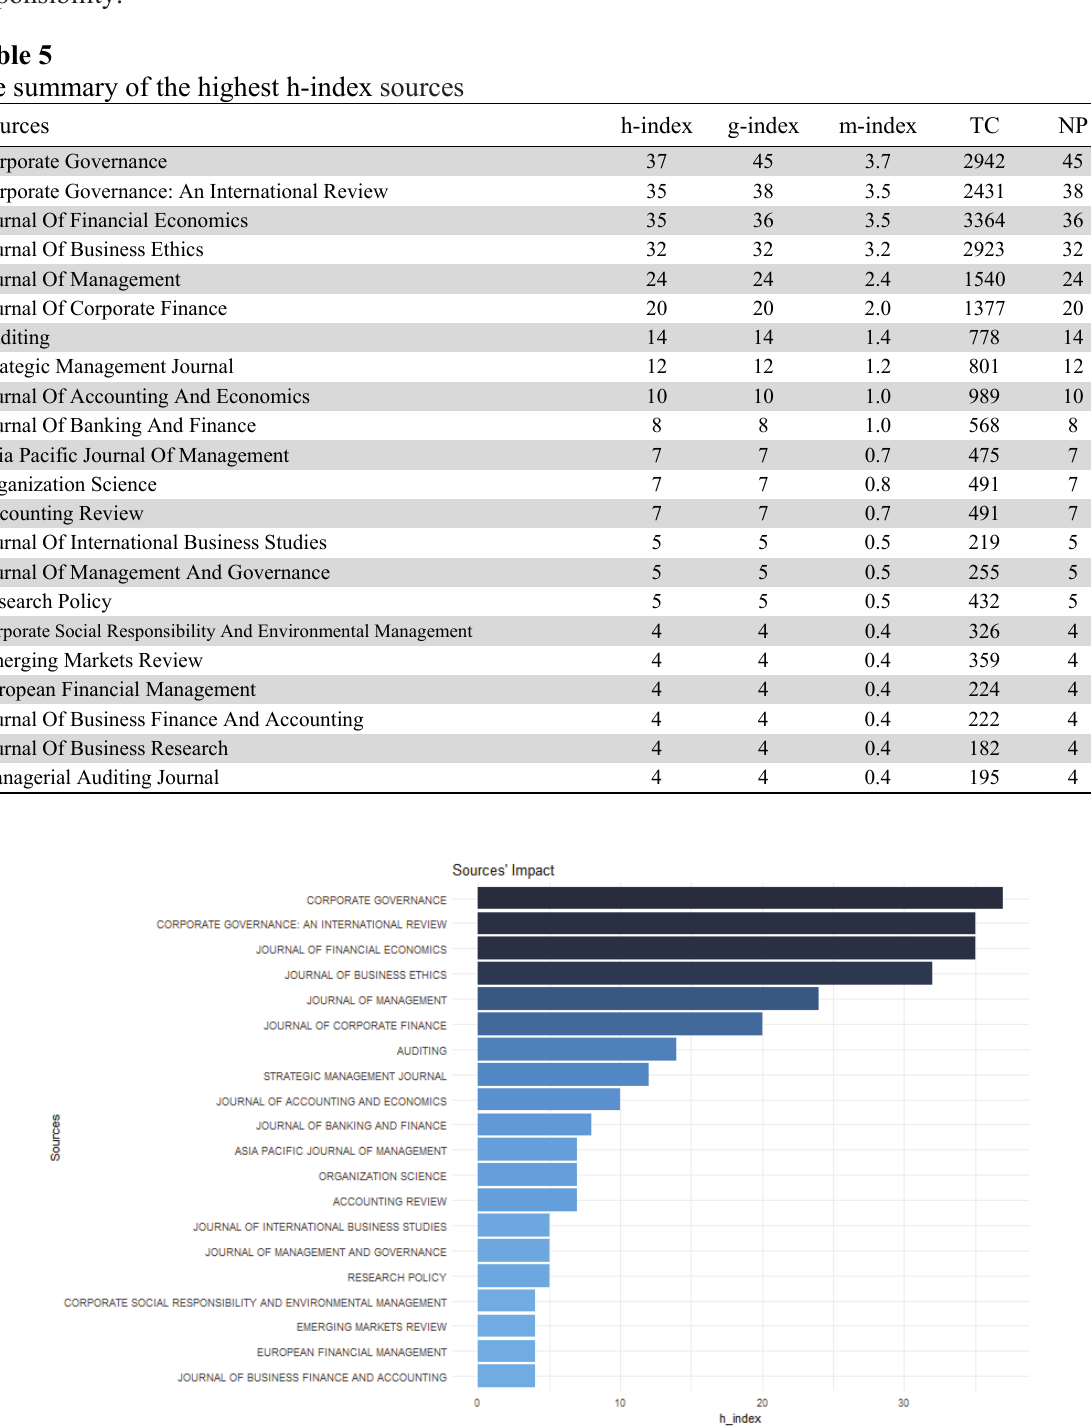
Fig. 7. The highest h-index sources associated with corporate